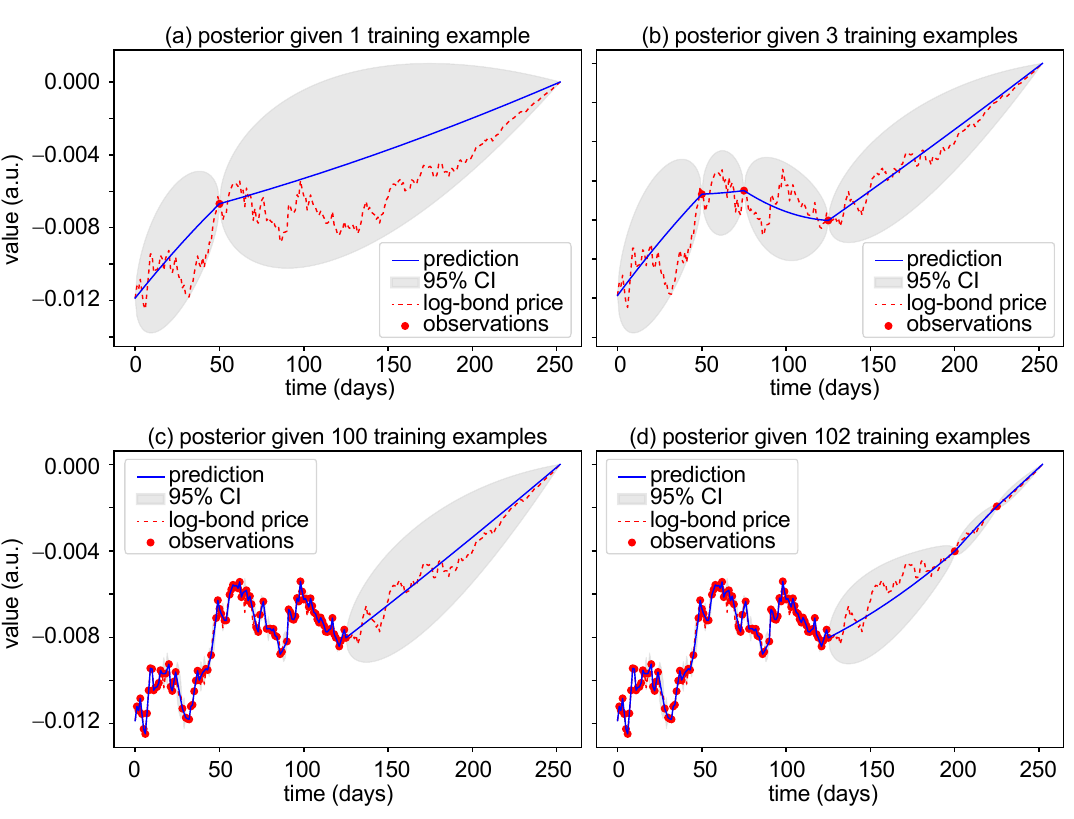
Figure 2. Illustration of Gaussian process posterior distributions, i.e., the prior conditioned on 1, 3, 100, and 102 observed training examples in ( a – d ), respectively. We want to predict log-bond-prices (red dotted line). The red dots constitute observations of the log-bond prices. The blue line denotes the posterior mean, which we take as prediction. The shaded areas represent the 95%